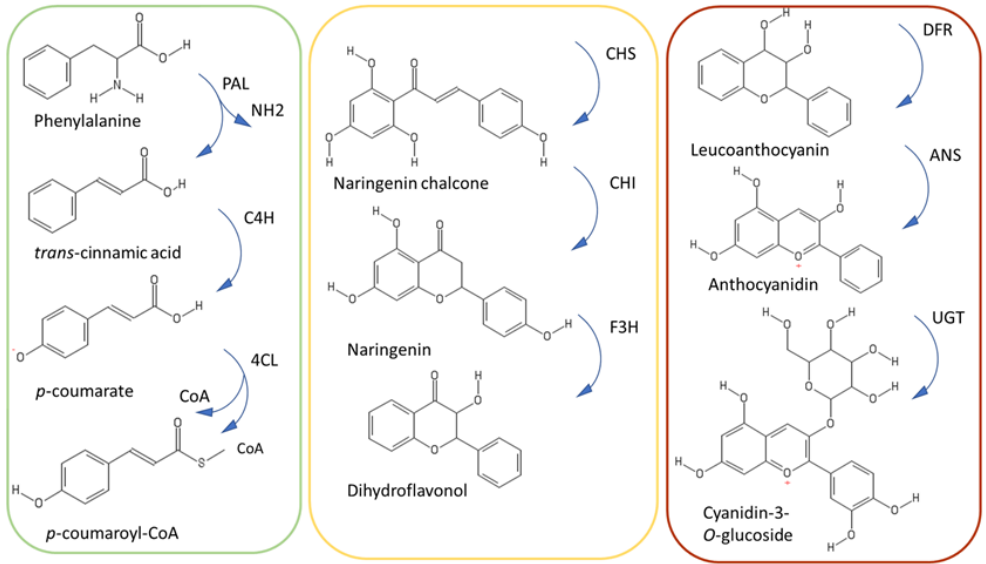
Figure 3. Simplified scheme of the phenylpropanoid pathway, with the upper, central and late steps in green, yellow and brown, respectively. UGT refers to